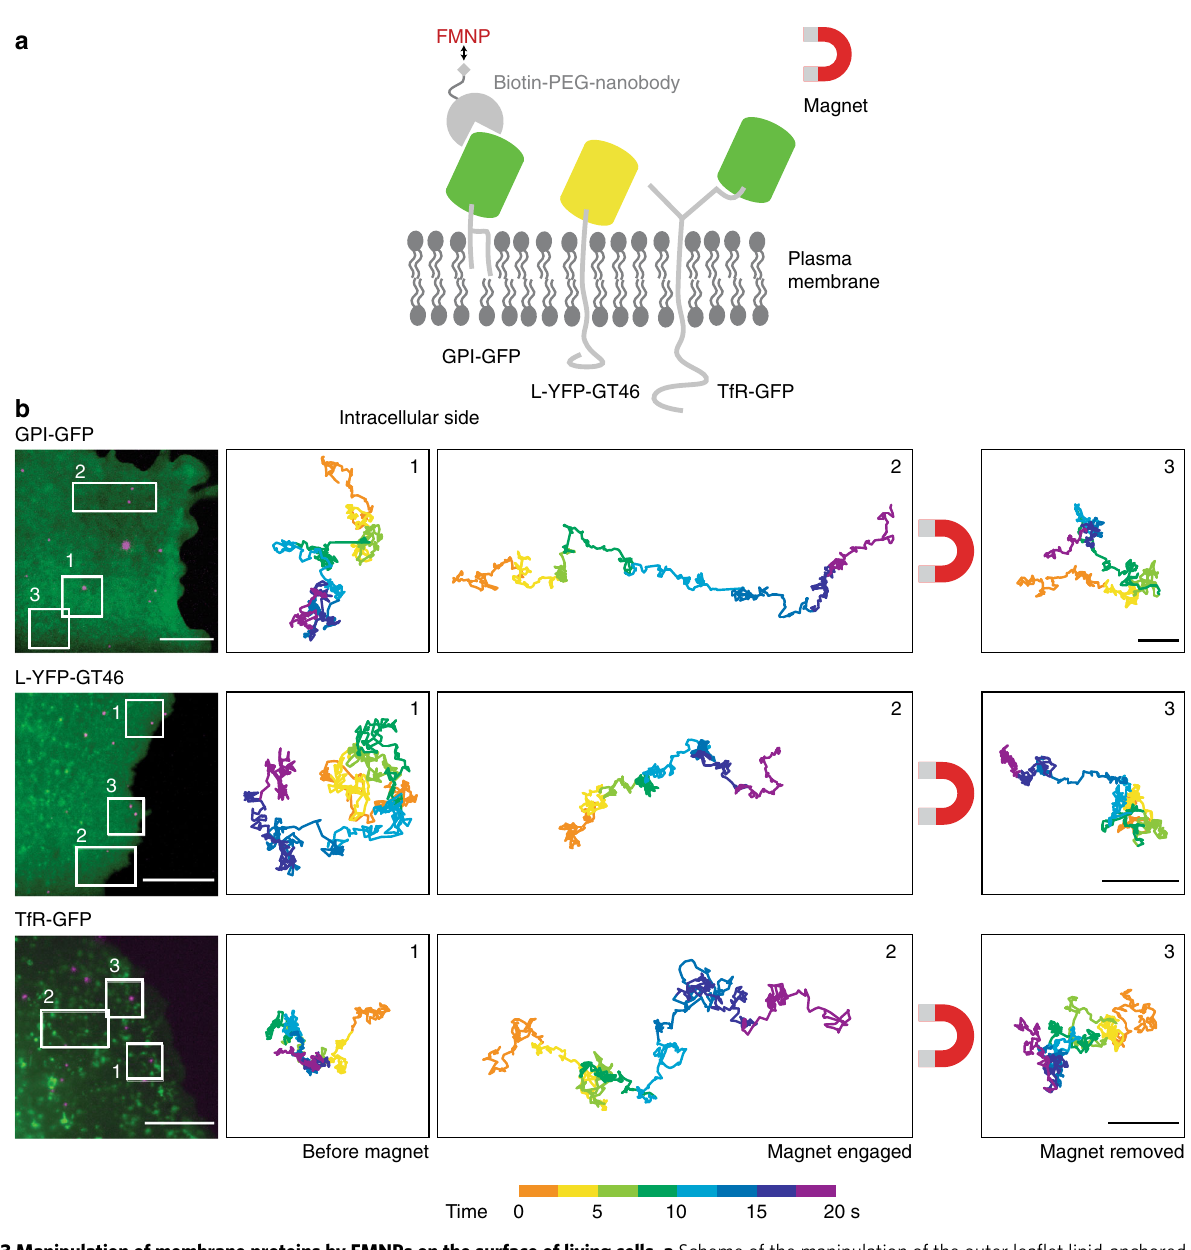
Fig. 3 Manipulation of membrane proteins by FMNPs on the surface of living cells. a Scheme of the manipulation of the outer lea fl et lipid-anchored (GPI- GFP) and transmembrane protein probes (L-YFP-GT46 and TfR-GFP) in living cells. The FMNPs are targeted to the fl uorescent protein moiety of membrane protein probes via biotinylated anti-GFP nanobodies and then pulled across the plasma membrane by a magnetic needle. Graphic is not to scale. b From top to bottom: Experiments of membrane protein probes pulled across the plasma membrane of living CV-1 cells expressing GPI-GFP, L-YFP-GT46, or TfR-GFP. Left: Fluorescence micrographs of single cells expressing the respective constructs (green) with bound FMNPs (magenta). Scale bars are 10 μ m. Right: Trajectories of exemplary FMNPs that moved in the white-framed areas on the cell before (1), during (2) and after (3) magnet engagement. Trajectories are color coded for time. Scale bars are 1 μ ten times with SLB buffer and evaluated on the spinning disc confocal microscope Transfection System according to the supplier ’ s protocol for COS-7 cells. Cells were by fl uorescence recovery after photobleaching. SLBs were incubated with 1× 10 9 plated on glass-bottom dishes and imaged in imaging medium (Fluorobrite DMEM, 10% FBS, GlutaMAX, 10 – 30 mM HEPES; ThermoFisher Scienti fi c) 16 – 48 per ml FMNPs in SLB buffer with 1% BSA on the microscope until tens to hun- h after transfection. dreds of particles per fi eld of view had bound to the SLB, and then washed 5 – 10 times with SLB buffer before imaging. Particle functionalization and live-cell experiments . For live-cell experiments Cell culture . Wild-type Cercopithecus aethiops kidney fi broblasts (CV-1) were targeting GFP or YFP, LaG-16 anti-GFP nanobodies 39 were recombinantly pro- a kind gift from the Helenius laboratory and grown in DMEM without phenol red, duced 40 and labeled. For the labeling reaction 41 , α -Biotin- ω -(succinimidyl pro- supplemented with 10% fetal bovine serum (FBS) and GlutaMAX (all Thermo- pionate)-24(ethylene glycol) (Iris Biotech) was added to the nanobody at twofold Fisher Scienti fi c) at 37°C in a CO 2 -controlled humidi fi ed incubator. Stably molar excess. After puri fi cation via 7kDa MWCO Zeba Spin Desalting Columns (ThermoFisher Scienti fi c), the labeling ef fi ciency was estimated to be 0.06 dye per transfected GPI-GFP CV-1 cells were maintained with 50 μ g ml − 1 Geniticin protein by labeling with Alexa Fluor 647 carboxylic acid, succinimidyl ester in (ThermoFisher Scienti fi c) supplementing the culture medium. For transient parallel. The FMNPs were mixed with the biotinylated nanobody in a 10:1 to 1:2 transfection, CV-1 cells at 70 – 100% con fl uency were electroporated with the Neon